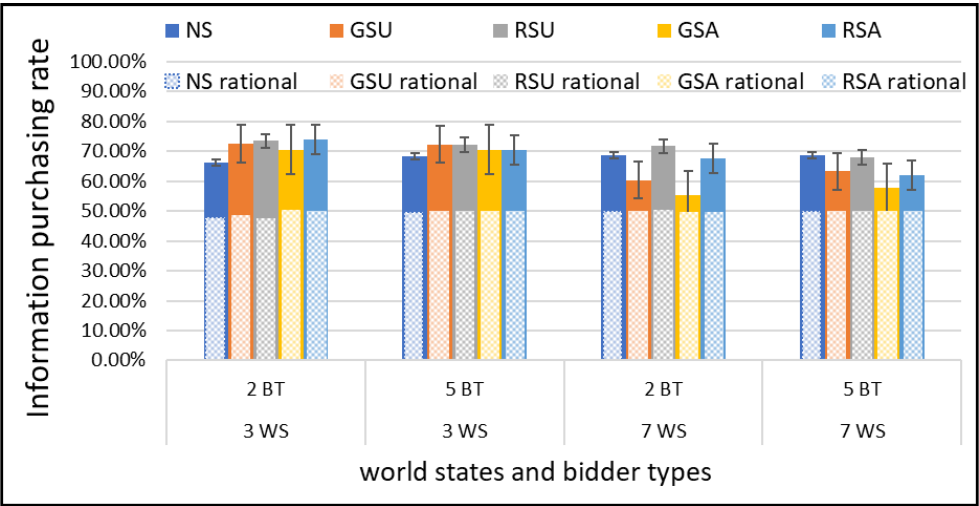
Figure 6. Information purchasing rate vs rational purchasing rate as a function of world states and bidder types.